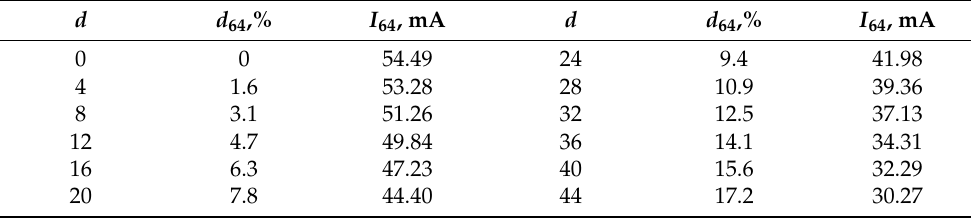
Figure 6. Current consumption charts for n = 16. The red line marks the maximum consumption current value that corresponds to the normal operation of the device. The yellow line captures the minimum consumption value that corresponds to the last experimental mode (disabling the synchronization of bits 0.11 in both operands). The green line shows the current consumption values measured at each moment of the experiment. The charts show, from left to right, the level of normal mode (15.74 mA), zero activity of input signals, return to the normal mode, and the sequential sync shutdown mode. In the case of d 16 = 6.3%, the current consumption decreases to the level of 13.72 mA, which is below the threshold S 16 . The results of the studies for n = 64 are shown in Table 4. Table 4. Results of experiments for n = 64.